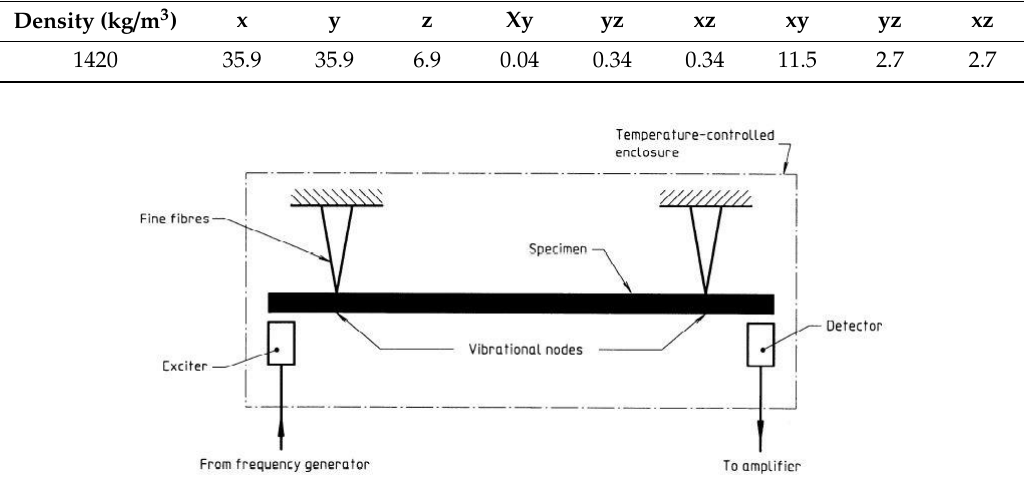
Figure 6. Experimental procedure for identifying resonance frequencies by external excitation [51] .